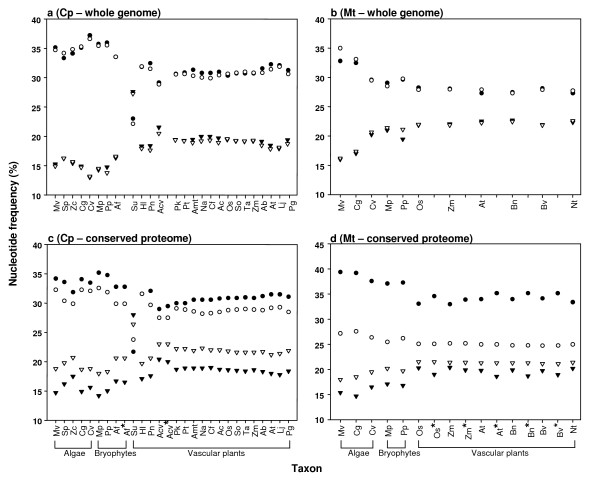
Nucleotide frequencies across streptophytes for whole genomes of chloroplasts (a) and mitochondria (b), and combined codon positions for the conserved proteomes of chloroplasts (c) (57 genes) and mitochondria (d) (13 genes). Nucleotides are represented by filled circles for T, open circles for A, open triangles for G, and filled triangles for C. The convergence of nucleotide composition can be observed across whole genomes and conserved proteomes. Taxa with available RNA editing data are duplicated and designated as "edit-repaired" by an asterisk. Taxa are arranged according to a phylogenetic sequence of [46] and divergence times are not considered. Broad taxonomic groupings are indicated on the X-axis below brackets. Taxonomic abbreviations are described in Additional file 3.